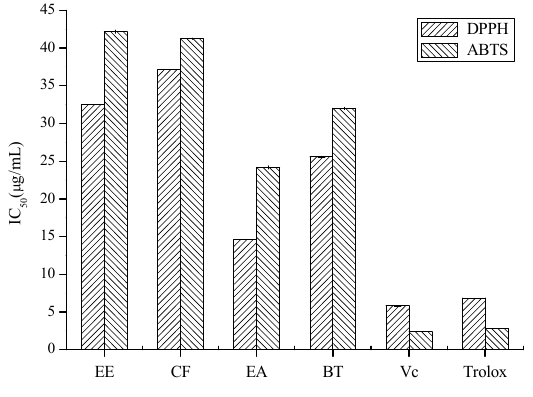
Figure 2. The DPPH and ABTS radical scavenging acitivities of ethanolic extract and three fractions from propolis collected in Anhui, China (EE, CF, EA, BT represent the ethanolic extract, chloroform, ethyl acetate and n -butanol fractions, respectively; L-Ascorbic acid (Vc) and Trolox were used as positive